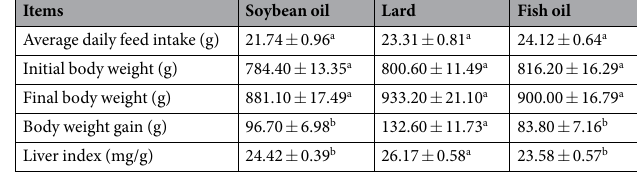
Table 1. Food intake, body weight gain and indices of rats after feeding for 3 months (means ± standard errors, n =